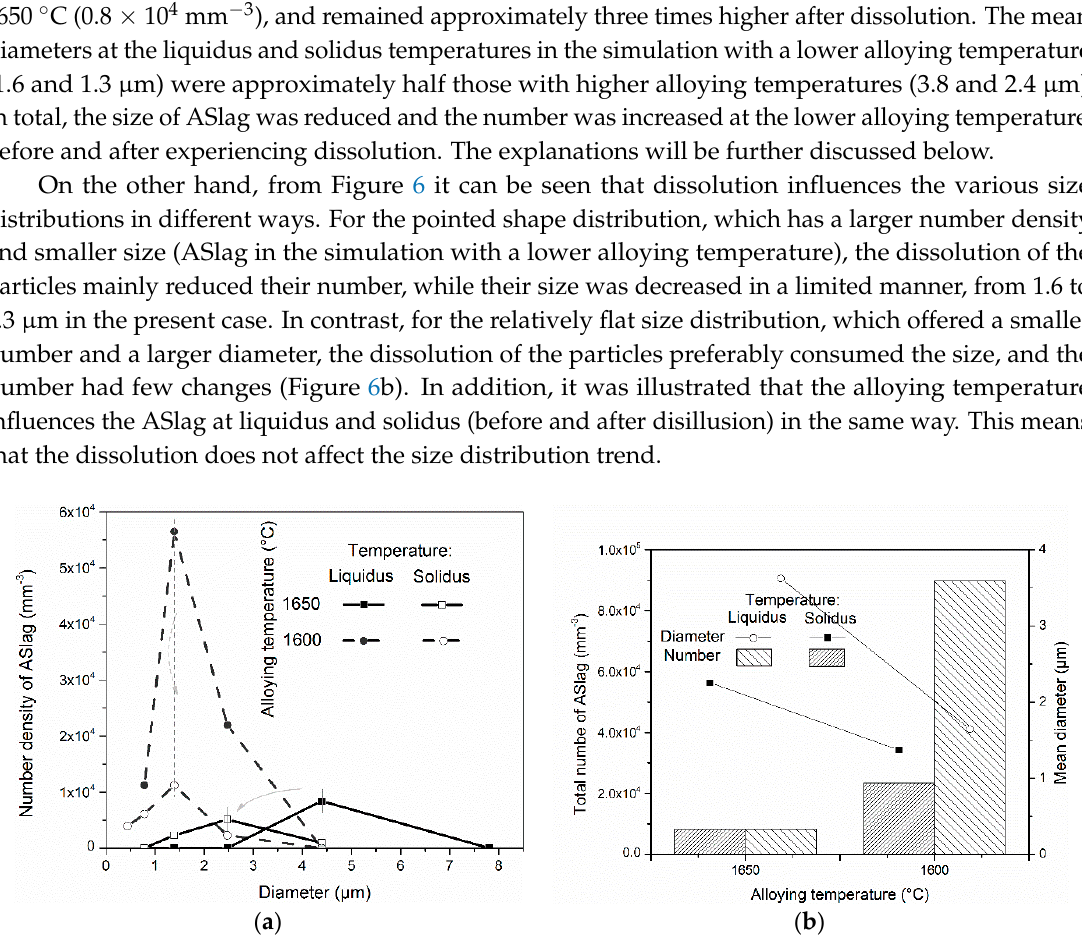
Figure 6. The influence of alloying temperature on ASlag ( a ) size distribution and ( b ) mean diameter and total number at solidus and liquidus temperature.